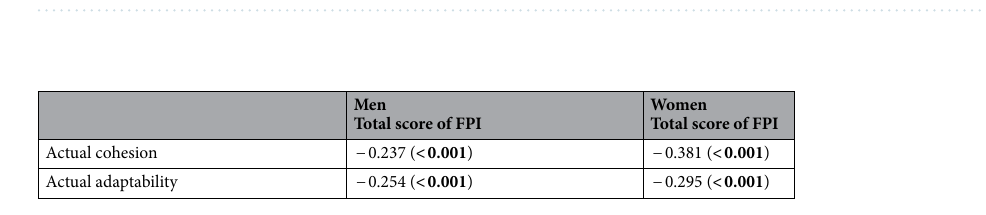
Table 6. Multiple comparisons of FPI scores of women with different education level (N = 508). Significant values are given in bold.